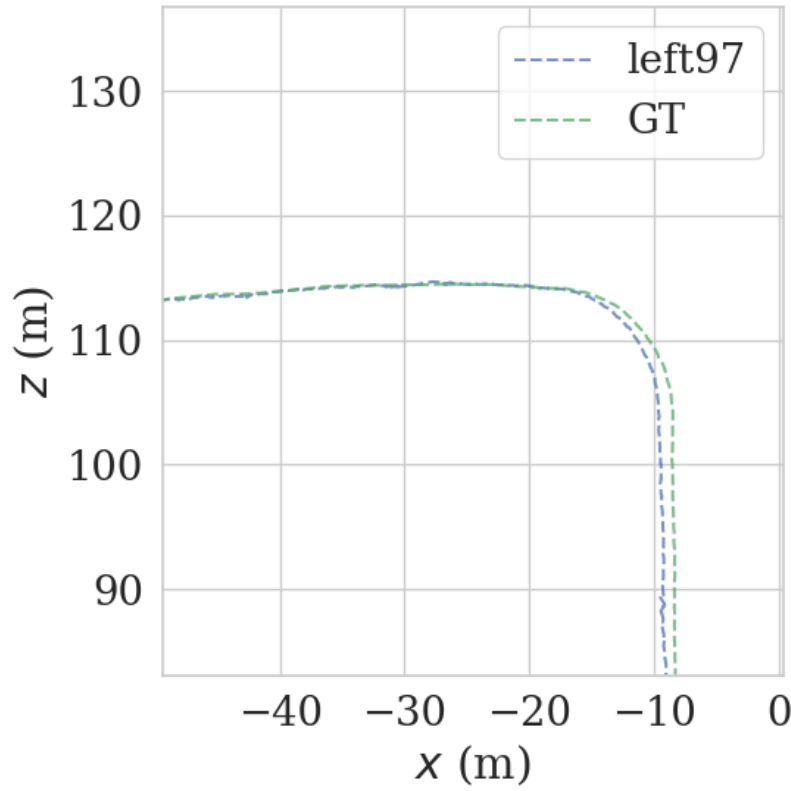
Figure 15. Track error using left LiDAR data at curves.